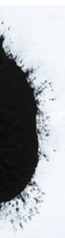
Figure 2: Carbon nanotubes. Table 1: Multi-walled carbon nanotubes.